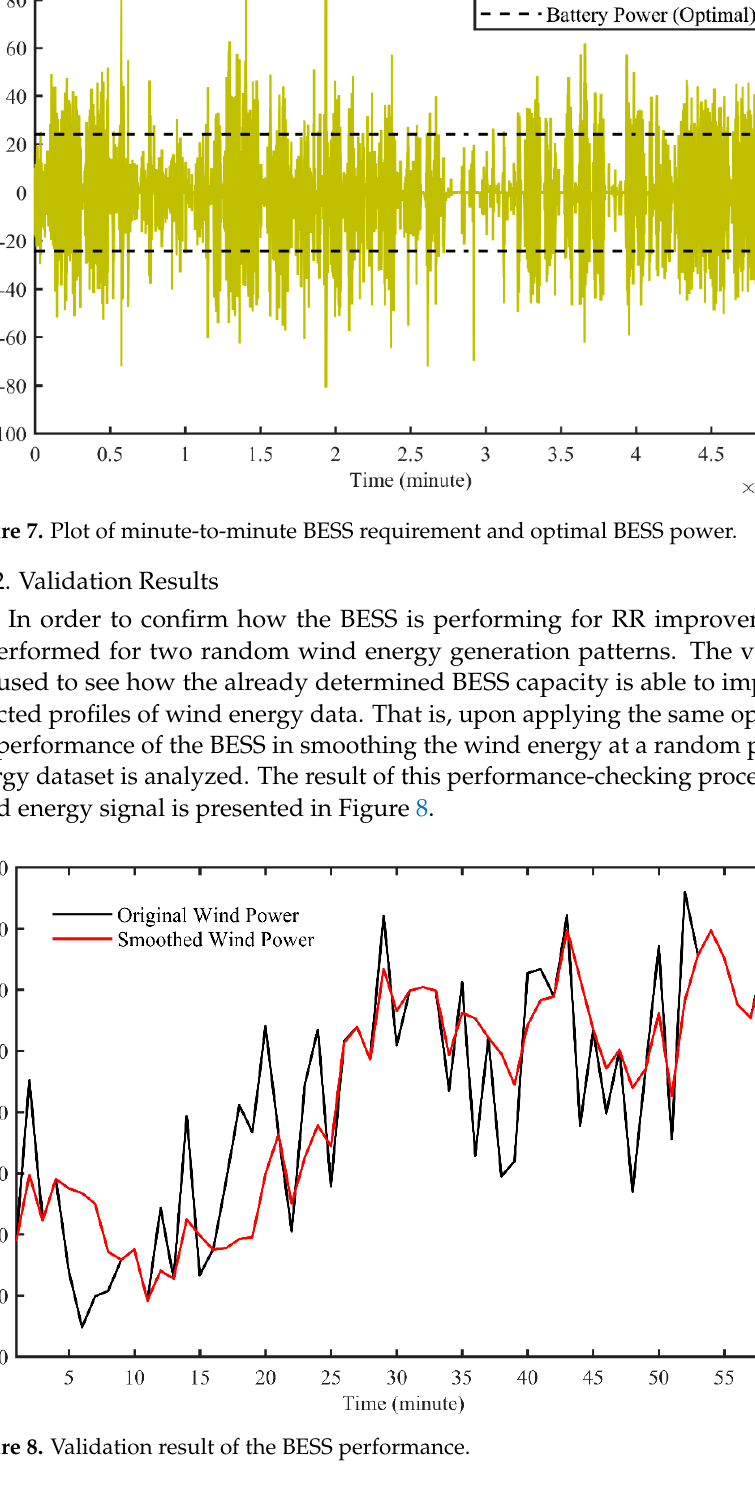
Figure 8. Validation result of the BESS performance.